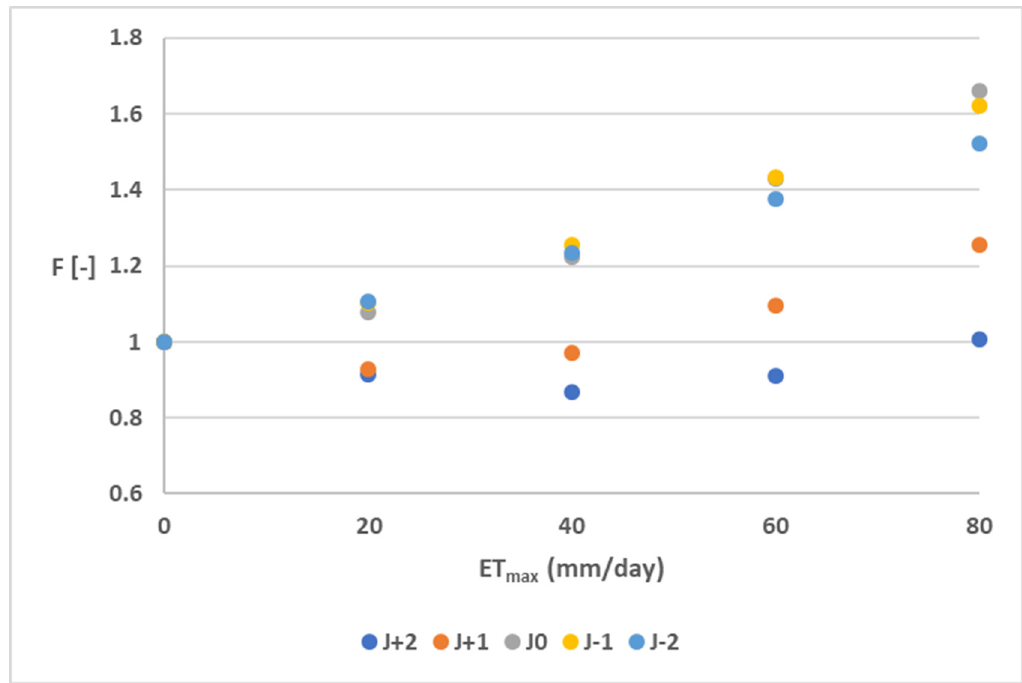
Figure 5. Normalized dimensionless flux ( F ) for each regional groundwater flux ( J y/x ; positive for gaining, negative for losing) scenario, plotted as a function of ET max .